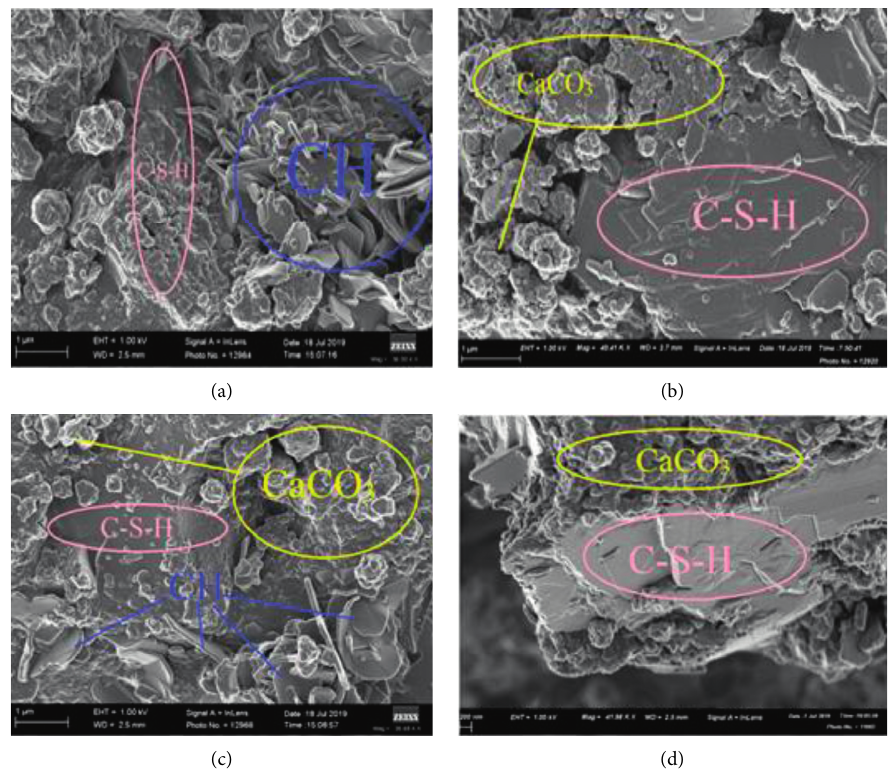
Figure 3: SEM analysis for (a) OPC-H 2 O (H 2 O), (b) OPC-H 2 O (LB), (c) OPC-LB (H 2 O), and (d) OPC-LB (LB).